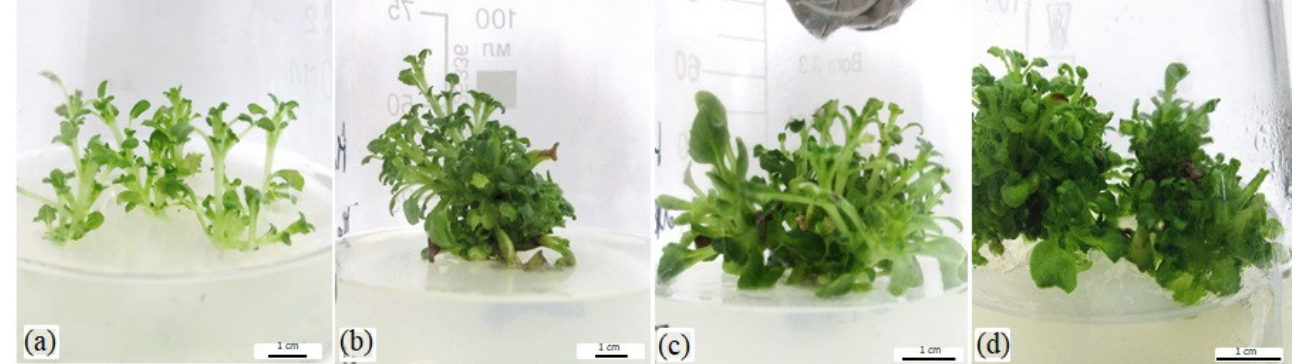
Figure 4. Microshoots of H. officinalis f. cyaneus obtained on MS nutrient medium supplemented with 0.1 mg/L IBA and BAP at concentrations of 0.3 mg/L ( a ), 0.4 mg/L ( b ), 0.5 mg/L ( c ) and 0.8 mg/L ( d ).